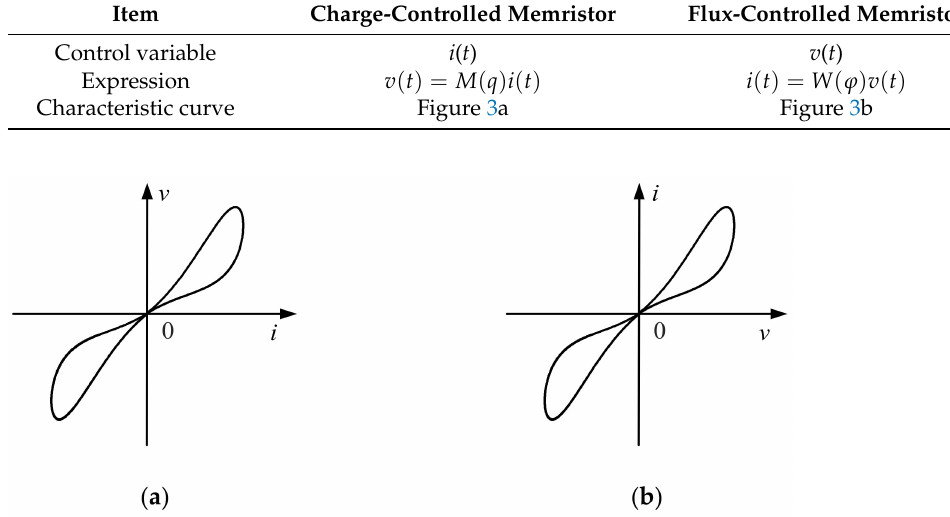
Figure 3. Volt–ampere characteristics of the memristor. ( a ) Current-controlled memristor (or charge- controlled memristor); ( b ) voltage-controlled memristor (or flux-controlled